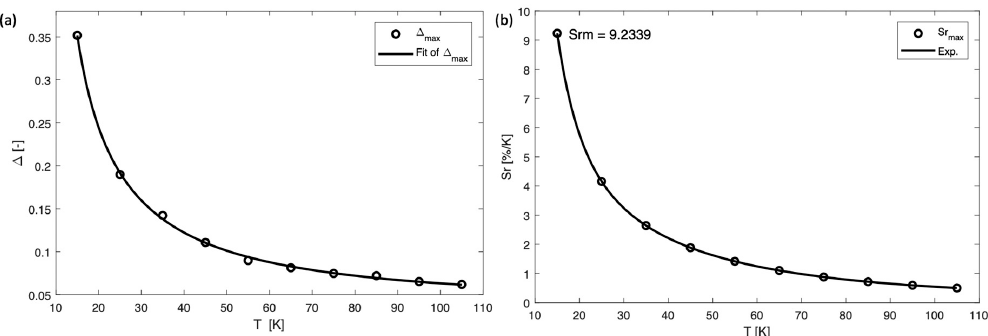
Figure 5. ( a ) Plot presenting the ∆ calculated at different temperatures and ( b ) plot showing the relativity sensitivity (S r ) at different temperatures.